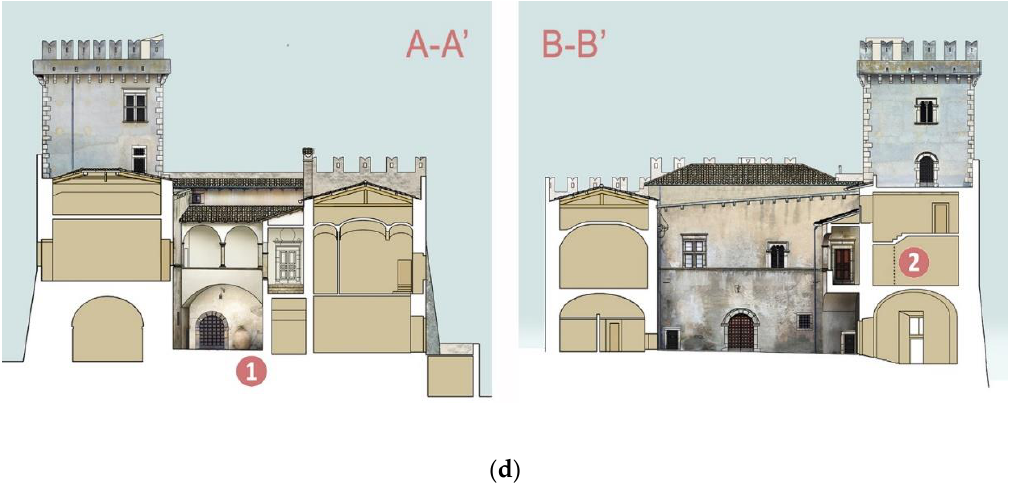
Figure 4. The actual configuration of the castle: ( a ) the north-east façade in the second half of the twentieth century (photo courtesy of the Municipal Historical Archive of Bussi); ( b ) the plan of the ground floor; ( c ) the plan of the ground floor; ( d ) elevations.